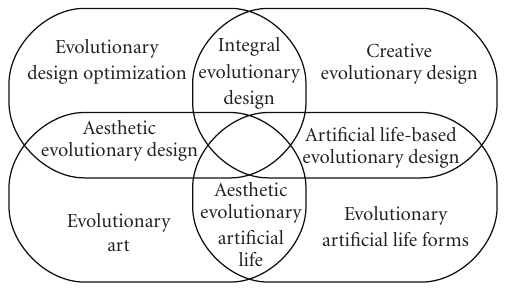
Figure 3: Evolutionary design